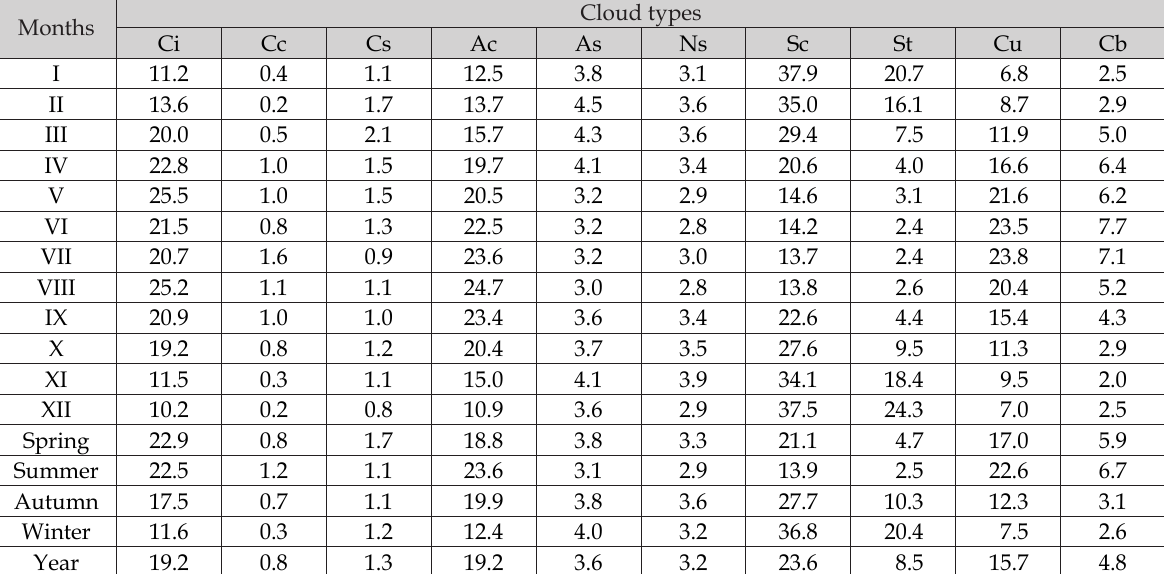
Table 3. Frequency of occurrence (%) of cloud types in Poznań